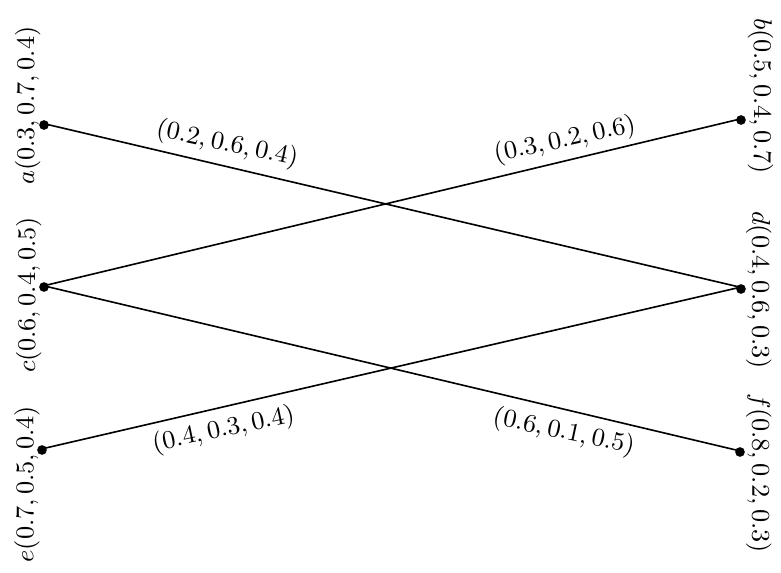
Figure 8. Strongly I-SFG G Figure 8: Strongly I-SFG G